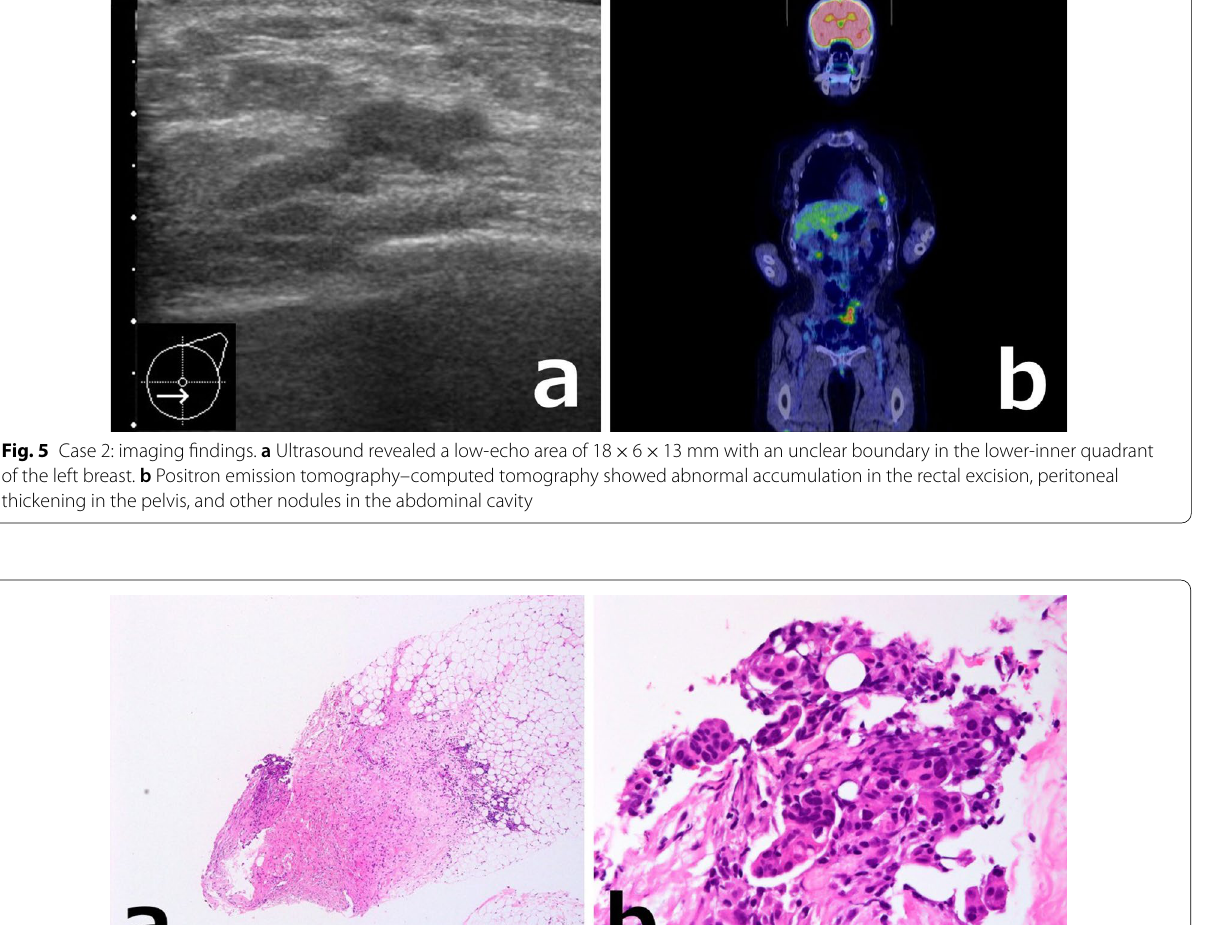
40. b 400. Vesicles of poorly differentiated cancer cells were × ×